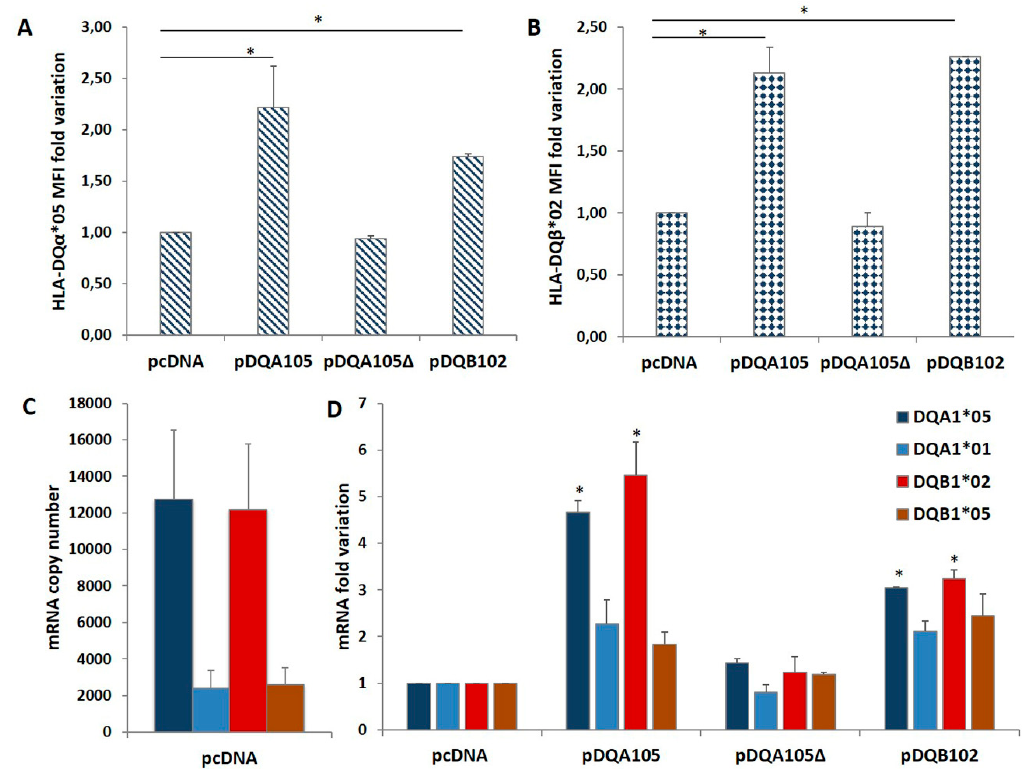
Figure 2. Coregulated expression of DQA1*05 and DQB1*02 CD risk alleles in DR1 / DR3 B-LCL#5. This cell line was transfected with pcDNA, pDQA105, pDQA105 ∆ , and pDQB102 constructs. The surface expression of DQ α 1*05 (panel A ) and DQ1 β *02 (panel B ) was measured by flow cytometry and reported as mean fluorescence intensity (MFI). The amount of DQA1*05 and DQB1*02 mRNA related to diseases, as well as the DQA1*01 and DQB1*05 mRNA, non-associated to pathologies, was reported as copy number in panel C and as fold variation in panel D . The p -value was calculated respect to cells transfected with empty vectors (* p < 0.05).